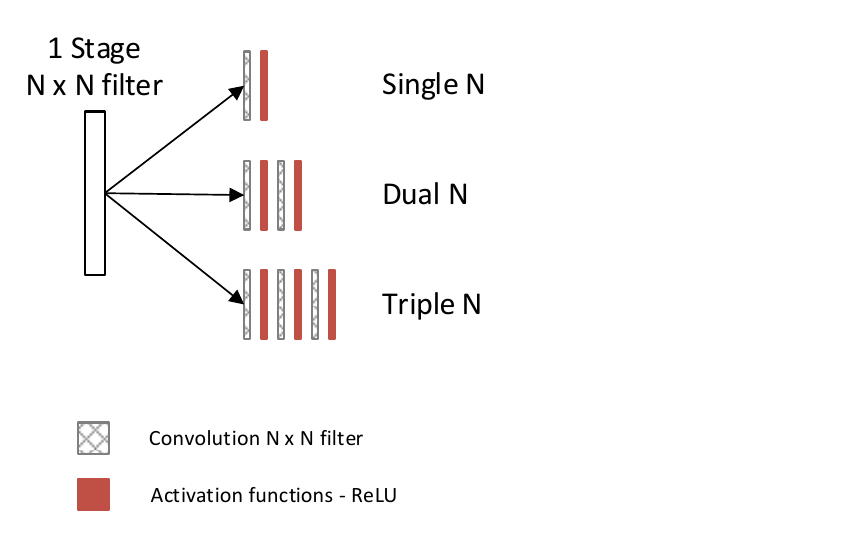
Figure 2. Each block in Figure 1 can become one of the options during testing. The naming in this paper is defined as Single N, Dual N, and Triple